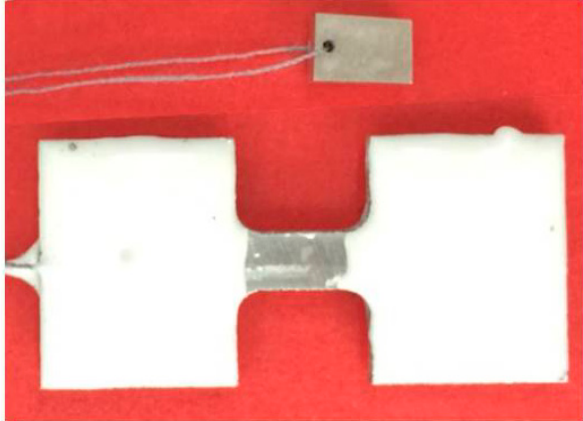
Figure 18. Image of specimen before immersion.